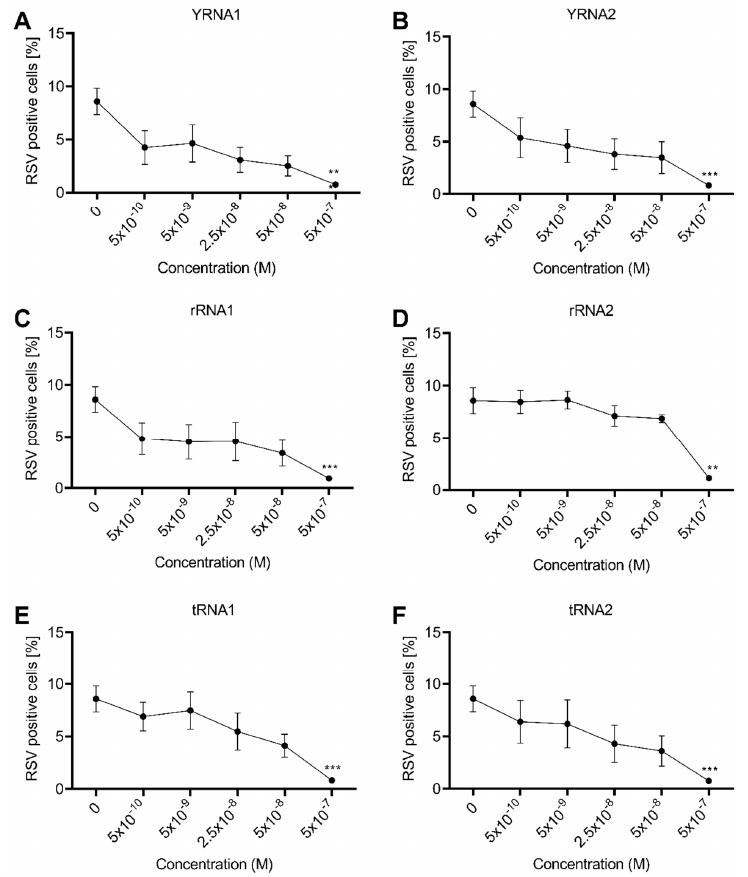
Figure 2. Small non ‐ coding RNAs inhibit RSV infection in a concentration ‐ dependent manner. A549 cells were treated with ( a ) YRNA1, ( b ) YRNA2, ( c ) rRNA1, ( d ) rRNA2, ( e ) tRNA1 or ( f ) tRNA2 at indicated concentrations for 30 min. Thereafter, cells were incubated with RSV at MOI 1 for 2 h. Subsequently, cells were washed, resuspended in media and incubated for 24 h. The recovered cells were stained with LIVE/DEAD ® Fixable near ‐ IR Dead Cell Stain Kit and the proportion of viable infected cells was measured 24 h post infection using flow cytometry. The data are presented as mean ± SEM from three independent experiments conducted in duplicate. Significant differences were assessed using the Kruskal–Wallis one ‐ way ANOVA test with Dunn’s multiple comparison, comparing each treatment to the RSV ‐ infected control. p ‐ value: ** p ≤ 0.01; *** p ≤ 0.001. Lack of significance is not displayed in the figure.